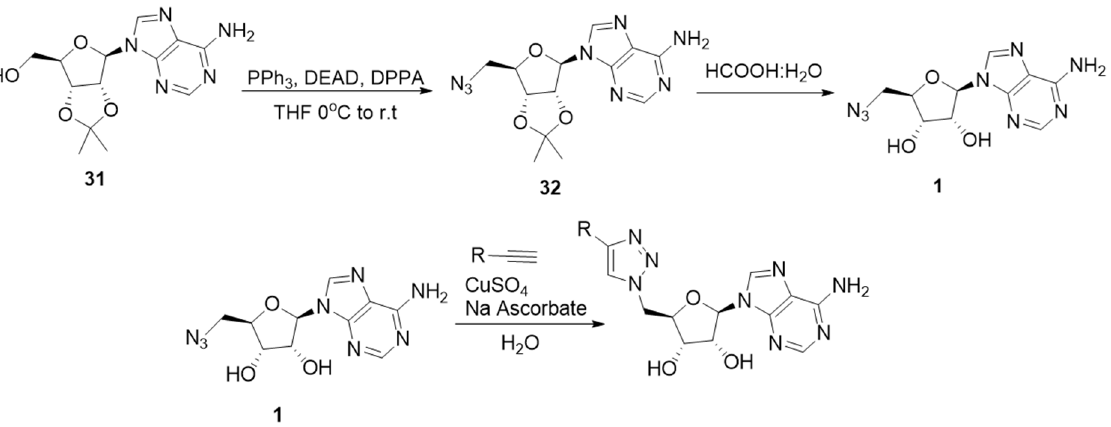
Figure 3. Overlay of docked SAM (orange) and 3 (green) showing the position of the triazole ring in relation to the sulfonium portion of SAM.